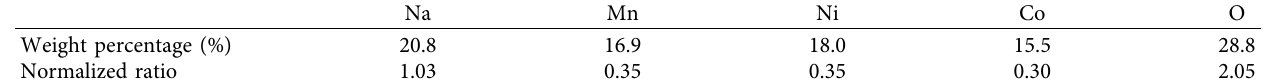
Table 1: The composition of various elements in the NaNMC sample.